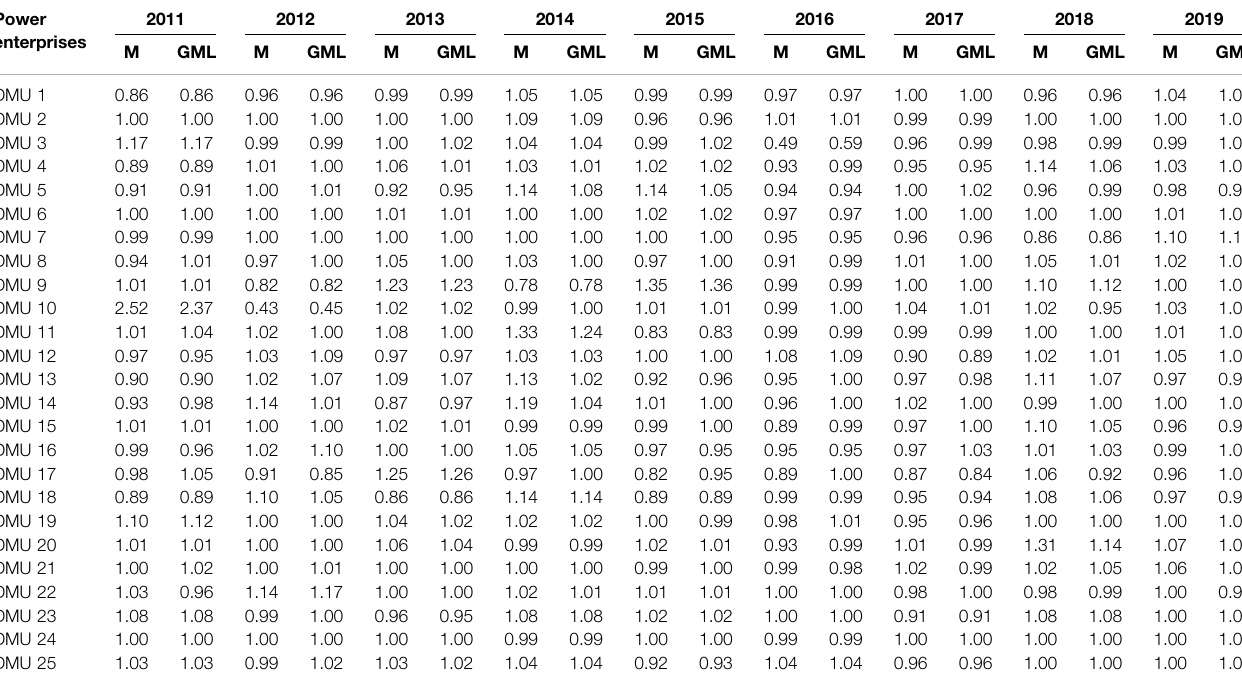
TABLE 3 | 2011 – 2019 Evolvement trend of M index and GML index. Power